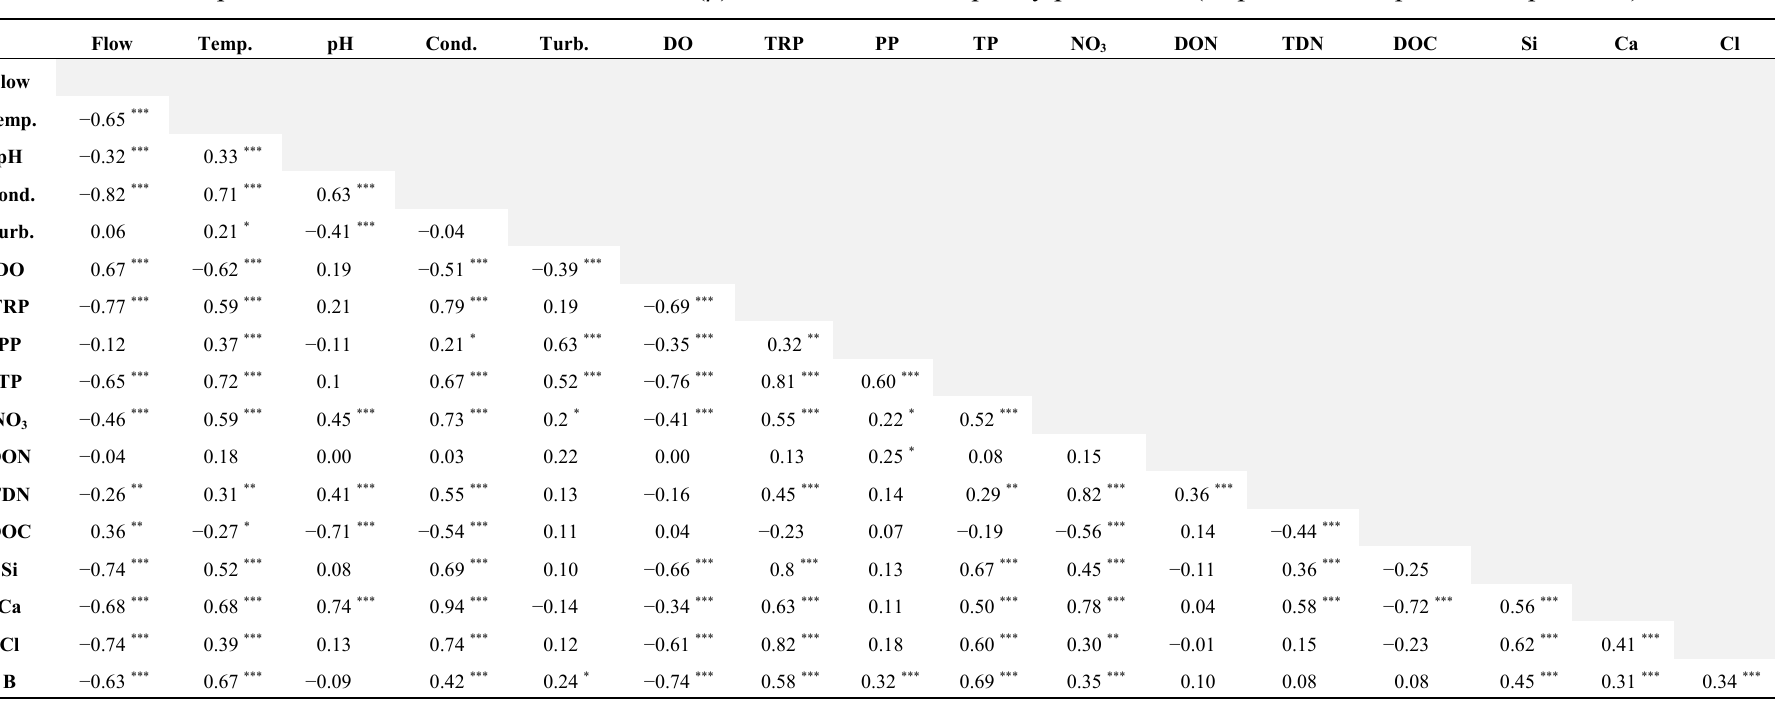
Table 8. Spearman’s rank correlation coefficients ( ρ ) between the water quality parameters ( *** p < 0.001; ** p < 0.01; * p < 0.05). Flow Temp. pH Cond. Turb. DO TRP PP TP NO 3 DON TDN DOC Si Ca Cl Flow